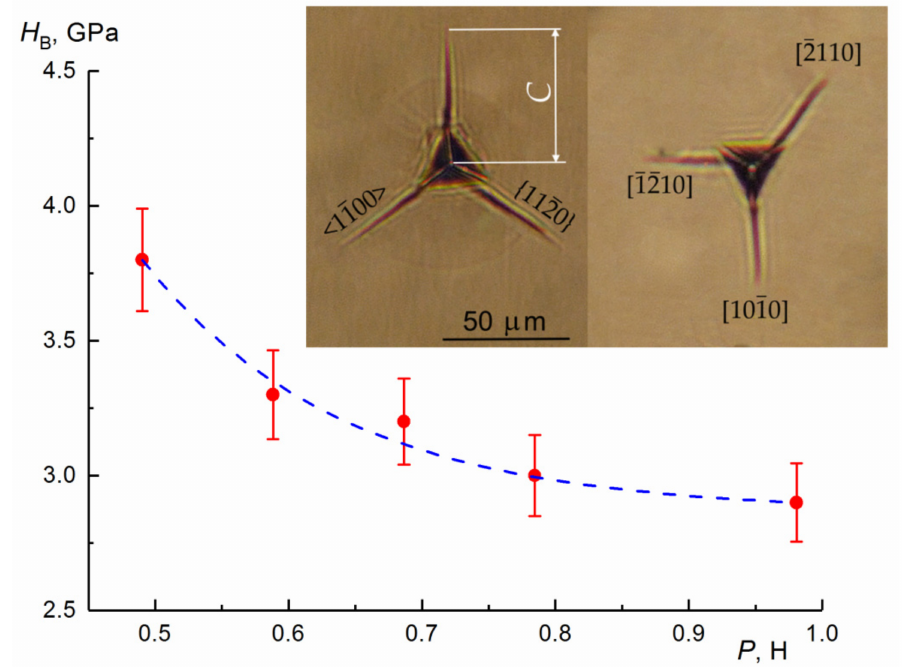
Figure 9. Dependence of the Berkovich microhardness H B of the (0001) plane of the CeF 3 crystal on the indenter load P and typical indentation patterns for the different indenter orientations ( P = 70 gf). C : linear dimensions of the